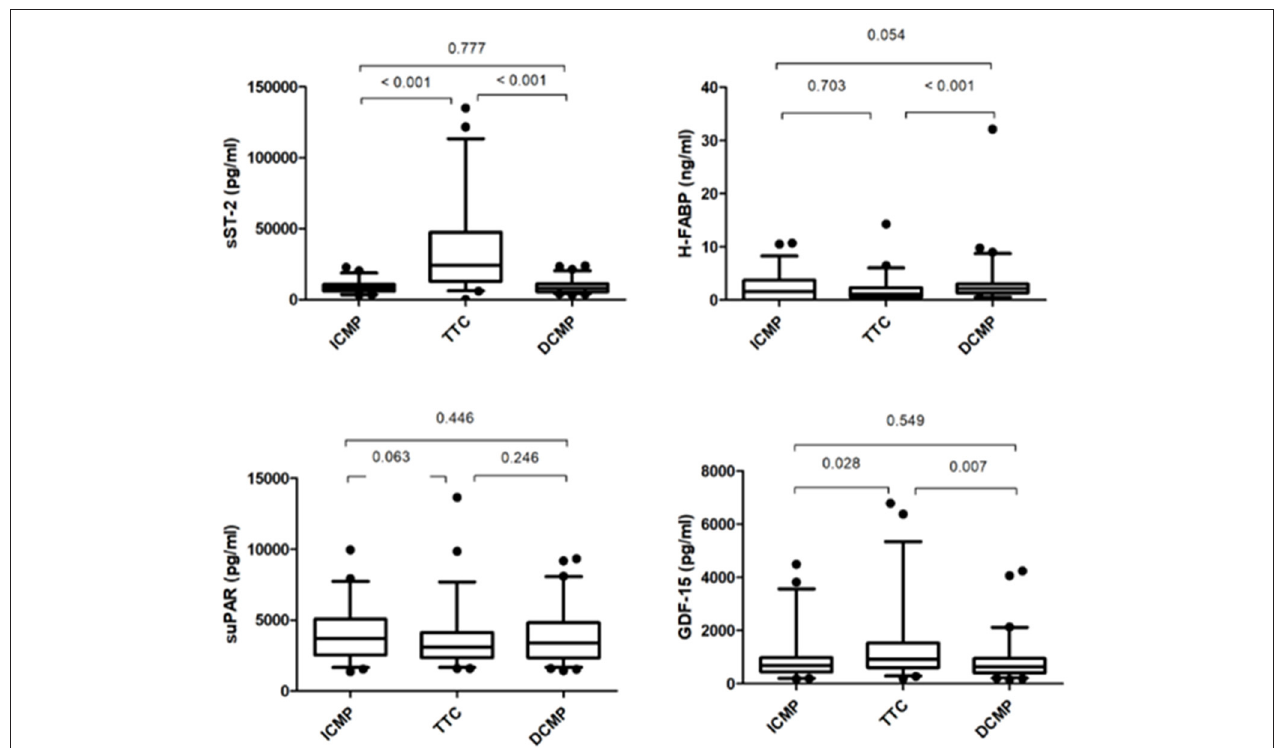
FIGURE 1 | Comparison of biomarker levels between ICMP group, TTC, and DCMP patients.